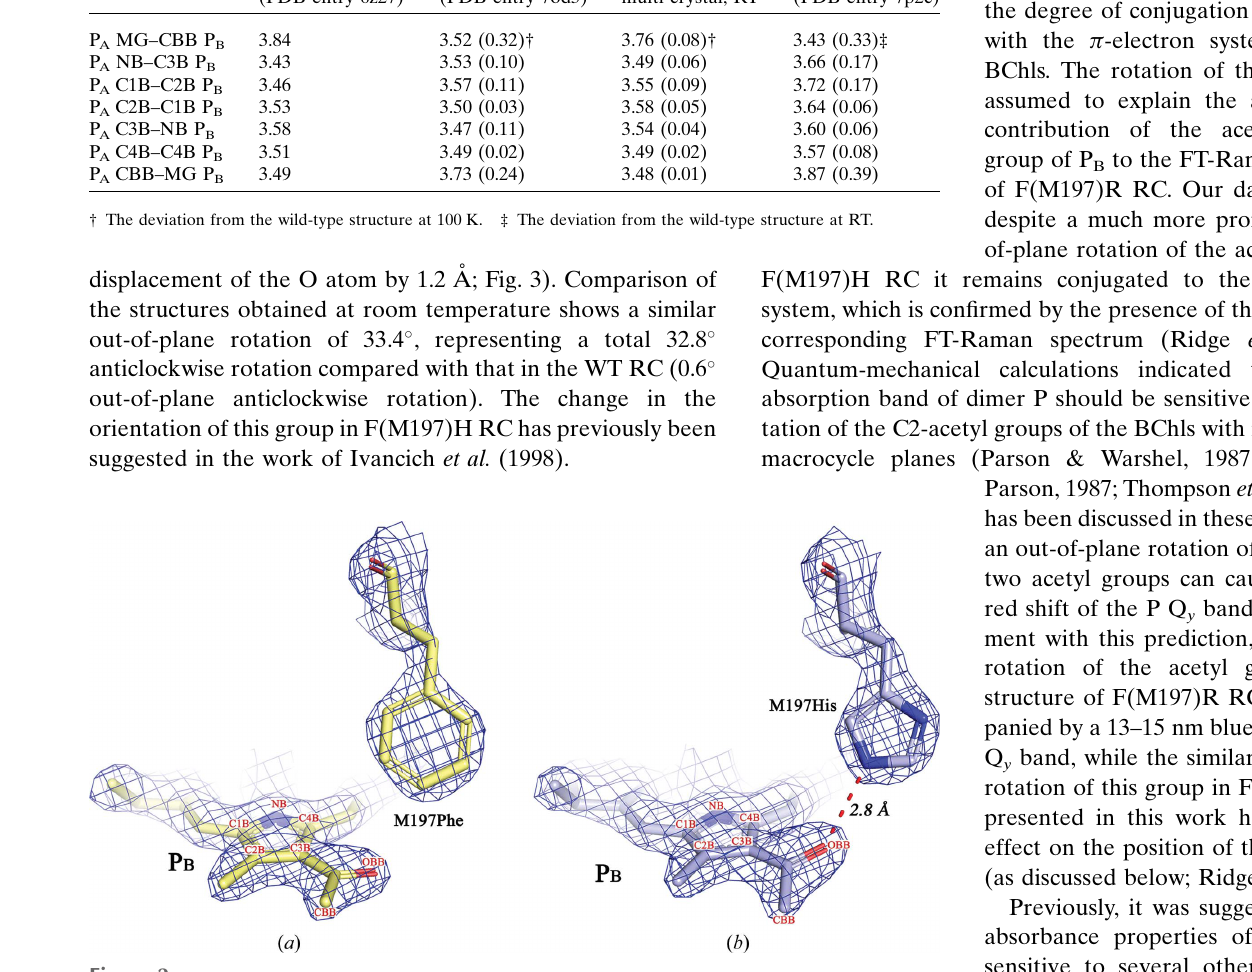
Figure 2 Electron-density maps for the WT RC ( a ) and F(M197)H RC ( b ) attributable to the M197 residue and the C2-acetyl group of BChl P B and the fits of the structural models to the density. 2.1 A˚ resolution, 2.0 (cid:3) [0.47 e A ˚ (cid:2) 3 for the WT RC and 0.63 e A ˚ (cid:2) 3 for F(M197)H RC].